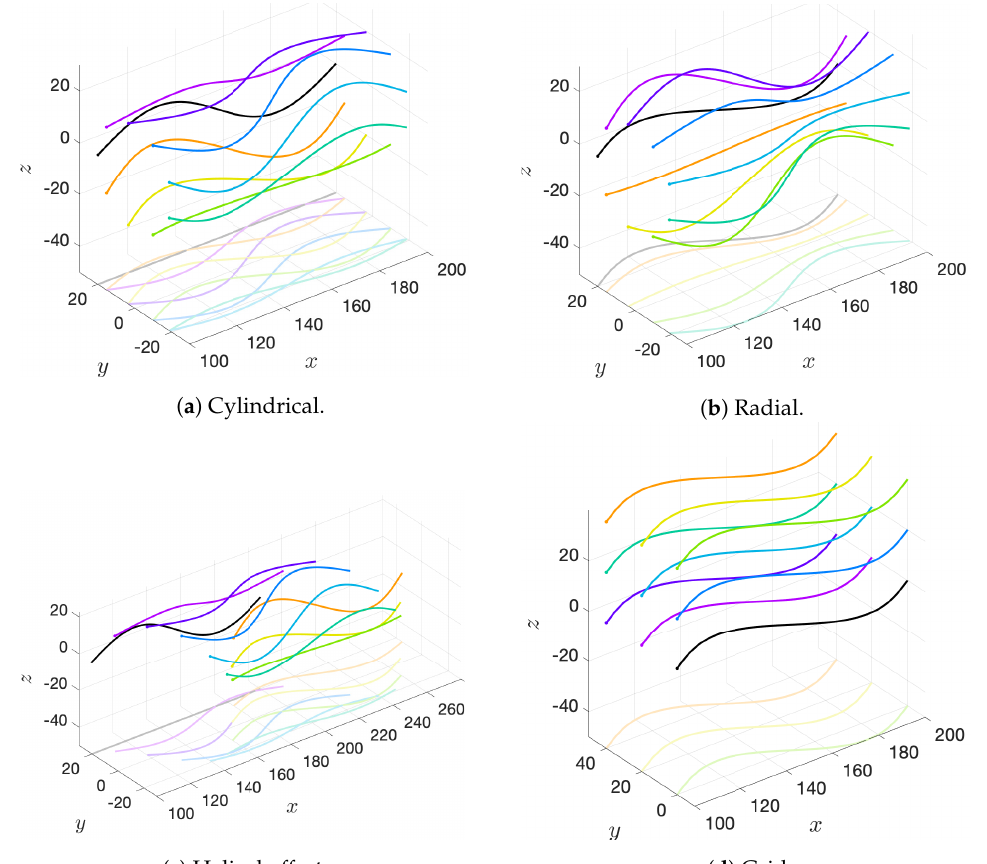
Figure 4. Examples of initial configurations of simulations. For ease of understanding the 3D configurations, we also show the “shadows” of each flagellum on the bottom plane, which is simply a projection of the flagellum onto the z = − 50 µ m plane. All units are in µ m and 9 flagella are shown.